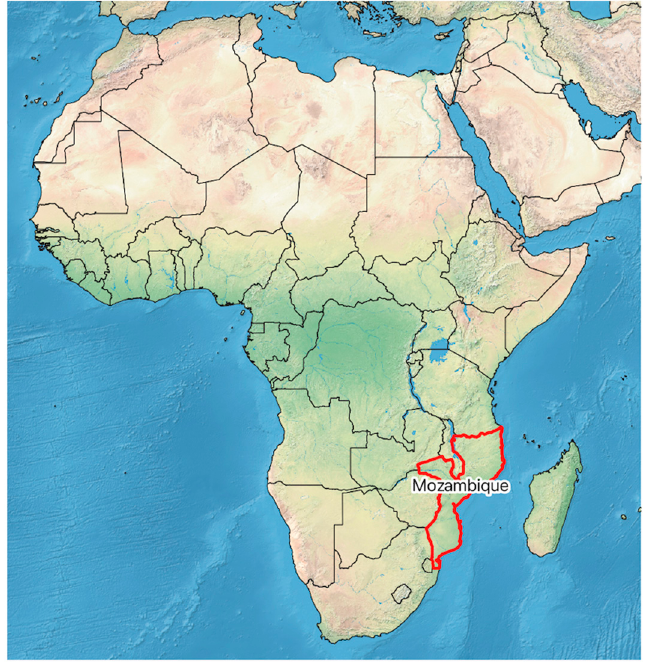
Figure 1. Location of Mozambique in Africa (Source: Natural Earth).